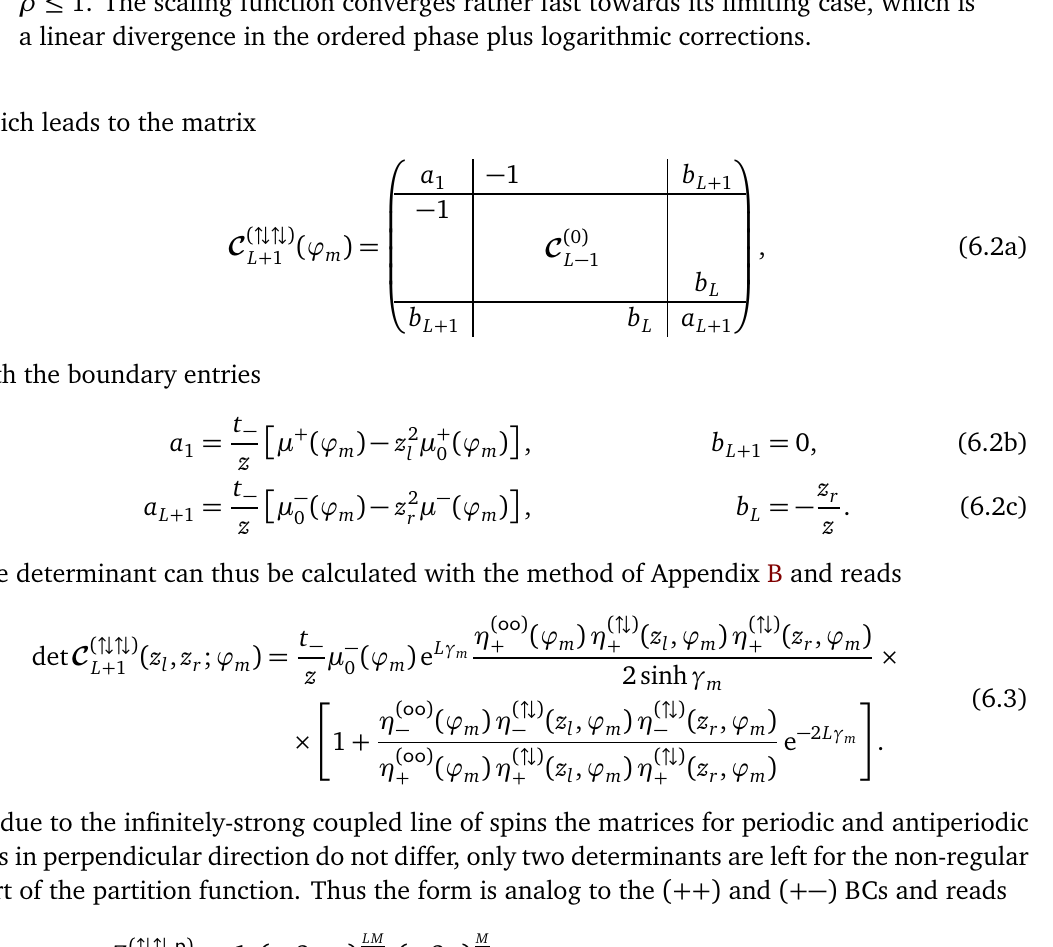
(+ − , p ) ( x ρ ) for different values of the aspect ratio ⊥ , ⊥